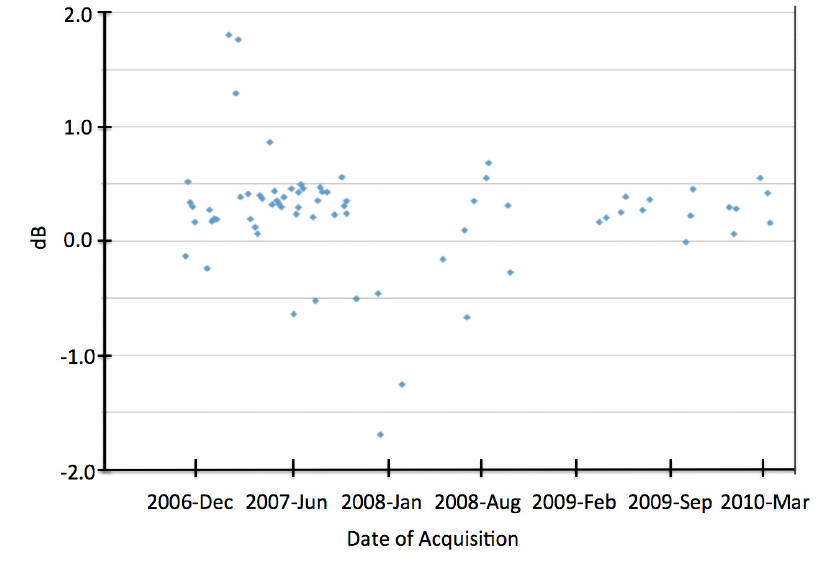
Figure 2. Average mean-difference between average image brightness and each of 70 ScanSAR image strips in UTM grid-zone tile